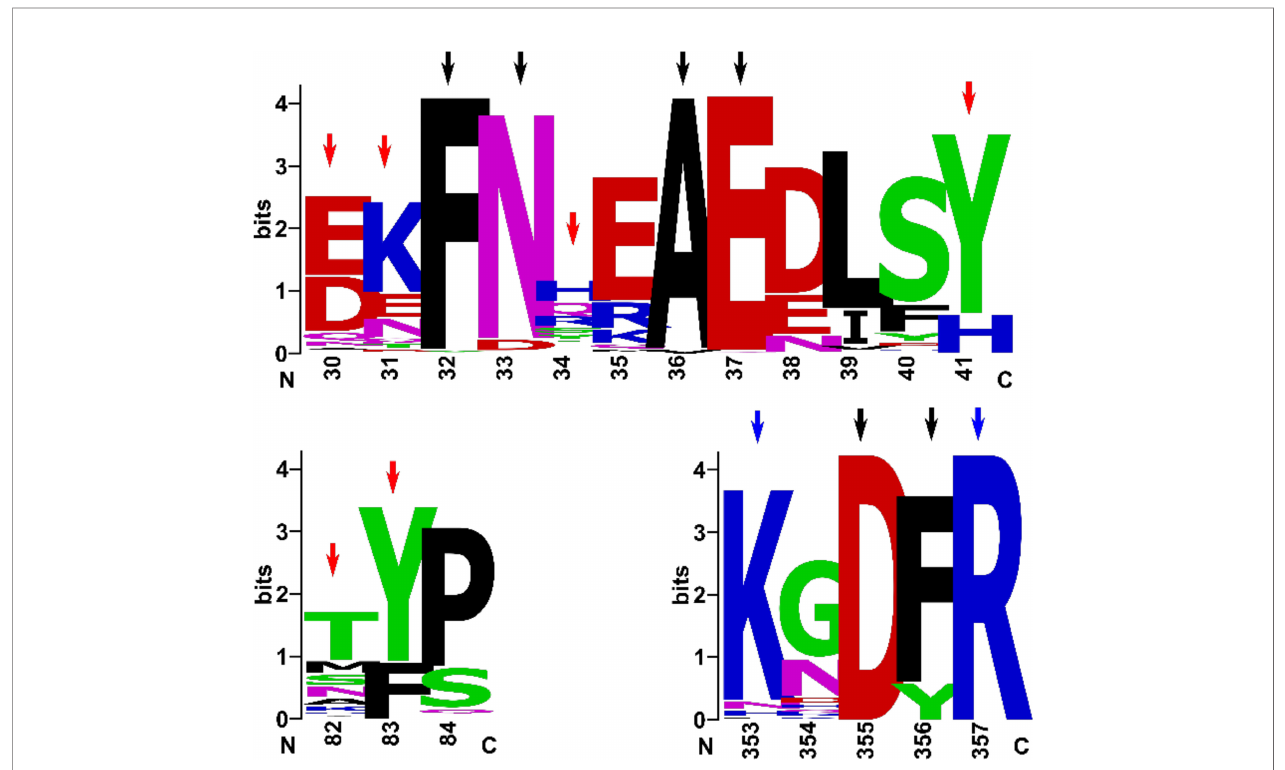
FIGURE 5 | Conservation of residues involved in direct contact between the receptor and the viral RBD. The fi gure shows sequence logo representation of alignments of residues 30-41, residues 82-84 and residues 353-357 of the host receptor (ACE2) from different species. The alignments involved 249 sequences that had the highest identity with the human ACE2 isoform 1 sequence. Highly conserved residues in this region are marked with black arrows. Conserved and non- conserved residues that are involved in direct contact with the viral RBD are marked with blue and red arrows, respectively.